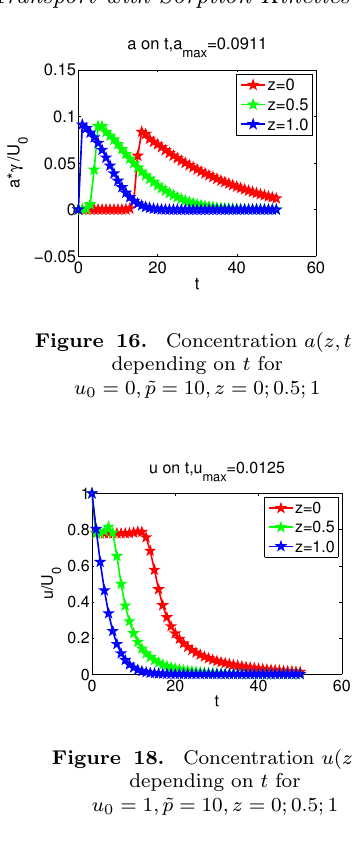
Figure 17. Concentration u ( z,t ) depending on t for u 0 = 1 , ˜ p = 1 ,z = 0;0 . 5;1